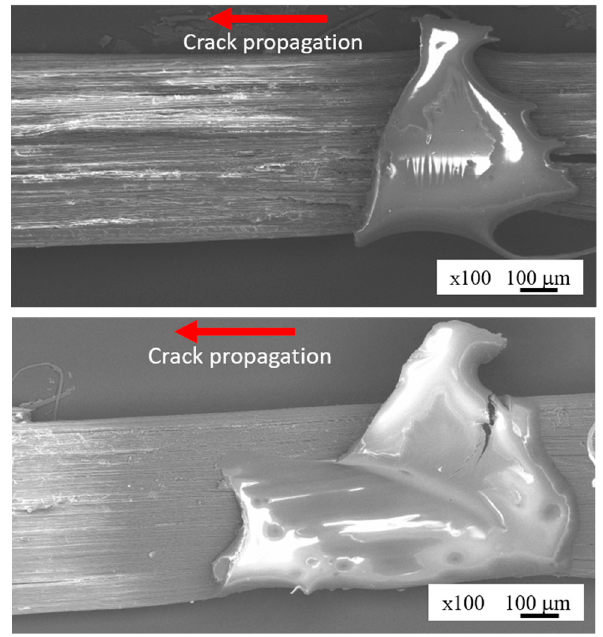
Figure 16. The specimen fracture surface.